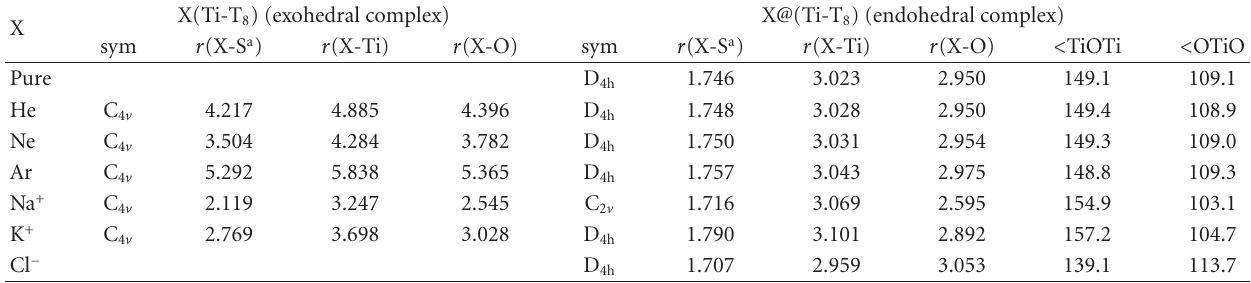
Table 2: Some geometrical parameters (˚A and degrees) of X(Ti-T 8 ) and X@(Ti-T 8 ); X = He, Ne, Ar, Na + , K + , Cl − at the B3LYP/6-311+G(d) level.